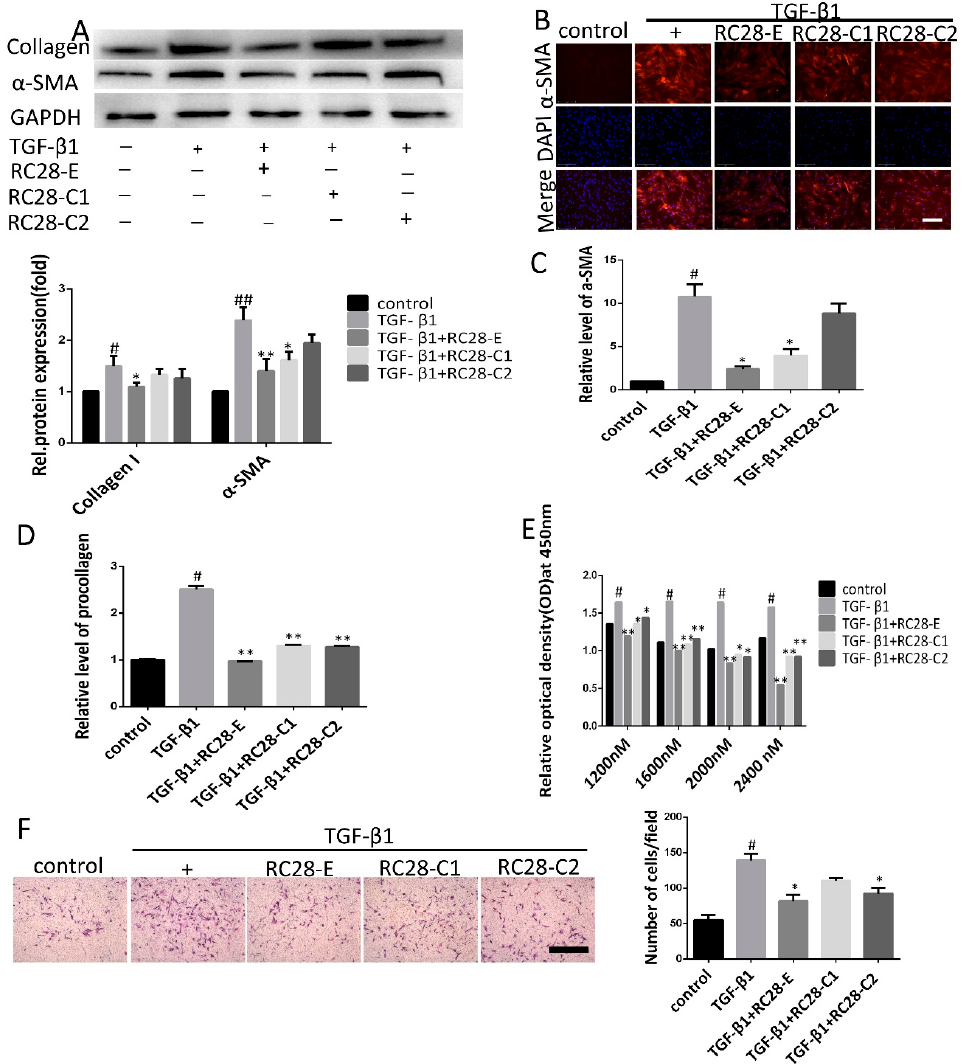
Figure 6. RC28-E attenuates TGF- β -induced fibroblast activation. ( A – D ) Human skin fibroblasts line Detroit 551 were treated with RC28-E (2400 nM) or 2400 nM RC28-C1 (VEGF-trap) and RC28-C2 (FGF-trap) in the presence hTGF- β 1 (10 ng / mL) for 72 h. ( A ) The protein expression levels of α -SMA and collagen I were examined by western blot and GAPDH as loading control. Quantitative data were from western blot analysis (n = 3). ( B ) The expression of α -SMA was detected by immunofluorescence assay. Nuclei were stained with DAPI (blue). Scale bar = 275 µ m for each picture (original magnification: × 200). ( C , D ) Changes of α -SMA and procollagen transcripts were analyzed by qRT-PCR. ( E ) cells were treated with 1200, 1600, 2000, and 2400 nM RC28-E or 1200, 1600, 2000, and 2400 nM RC28-C1 (VEGF-trap) or 1200, 1600, 2000, and 2400 nM RC28-C2 (FGF-trap), with hTGF- β 1 (10 ng / mL) as the control, for 48 h. Relative cell proliferation was determined by using cell counting kit-8. ( F ) Transwell was used to migration analysis, the migrated cells were stained with crystal violet. Results are shown as mean ± SD. * p < 0.05, ** p < 0.01 versus hTGF- β 1 alone. # p < 0.05, ## p < 0.05 versus control (n = 3).